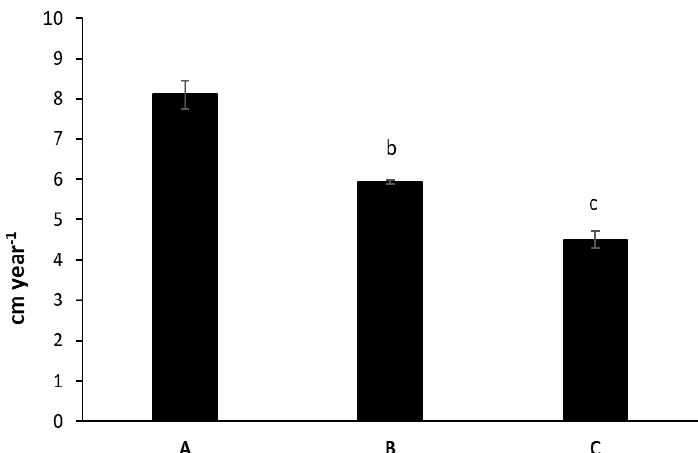
Figure 2. Average annual growth rate (cm year −1 ) at the three plantations. Values are reported as mean ± s.e. Different letters at the tops of the bars indicate a significant difference among values measured for the plantations.